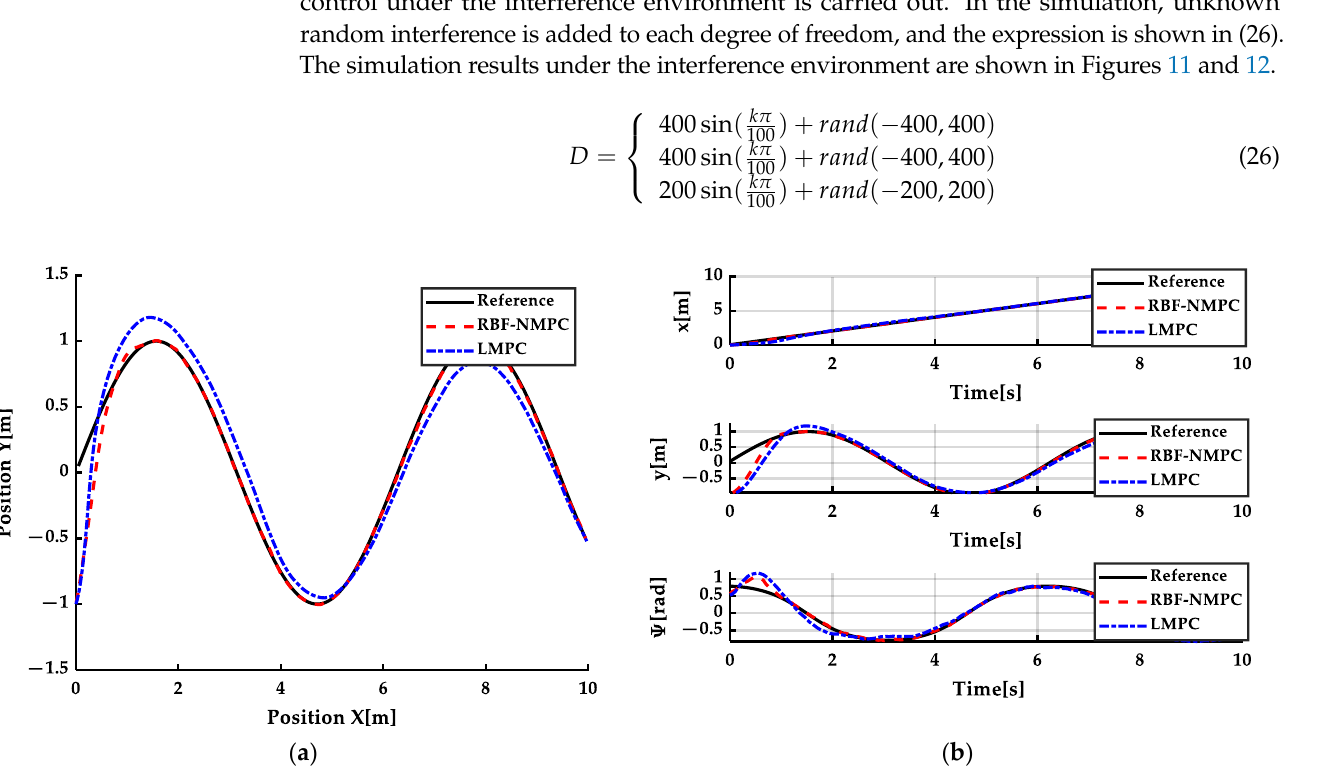
Figure 11. Tracking control comparison results under interference environment: ( a ) Tracking effect in xoy plane; ( b ) Tracking effect of each state.